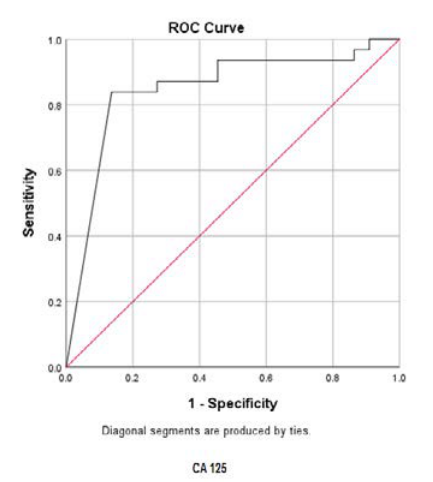
Fig. 2. ROC curve for CA125.